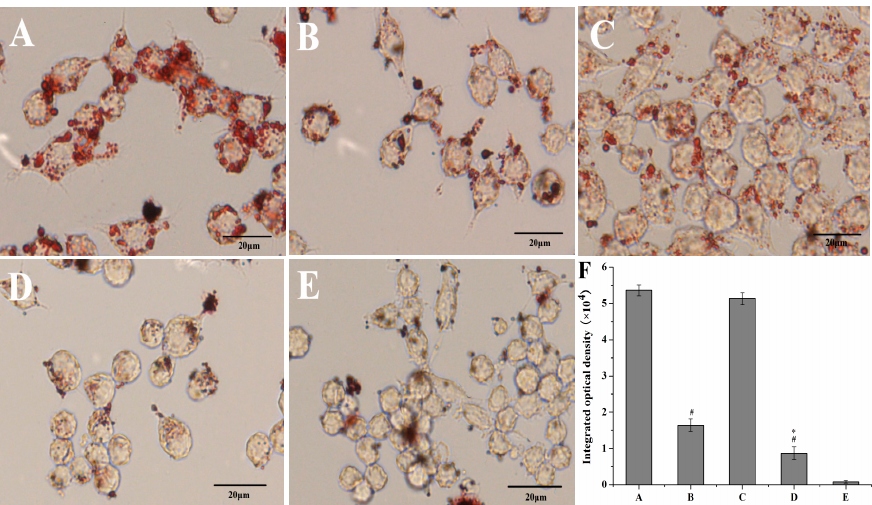
Figure 9. Oil Red O staining and integrated optical density of oxLDL-induced macrophages. ( A ) positive control group; ( B ) curcumin solutions; ( C ) blank PS-containing carriers; ( D ) Cur-mNLCs; ( E ) negative control group; ( F ) integrated optical density analysis; # p < 0.01, compared with A, * p < 0.05, compared with B. In panel F, the letters of A-E in the X axis correspond to Group A-E, respectively. Curcumin solutions or Cur-mNLCs markedly reduced oxLDL-induced cholesterol accumulation in macrophages ( p < 0.01 for Group B or D vs . Group A), and Cur-mNLCs exhibited more potent effects than curcumin solutions ( p < 0.05 for Group D vs . Group B). PS did not have an obvious effect on macrophages’ lipid uptake behavior ( p > 0.05 for Group C vs . Group A) (mean ± SD, n = 6). Scale bar is 20 μ m.